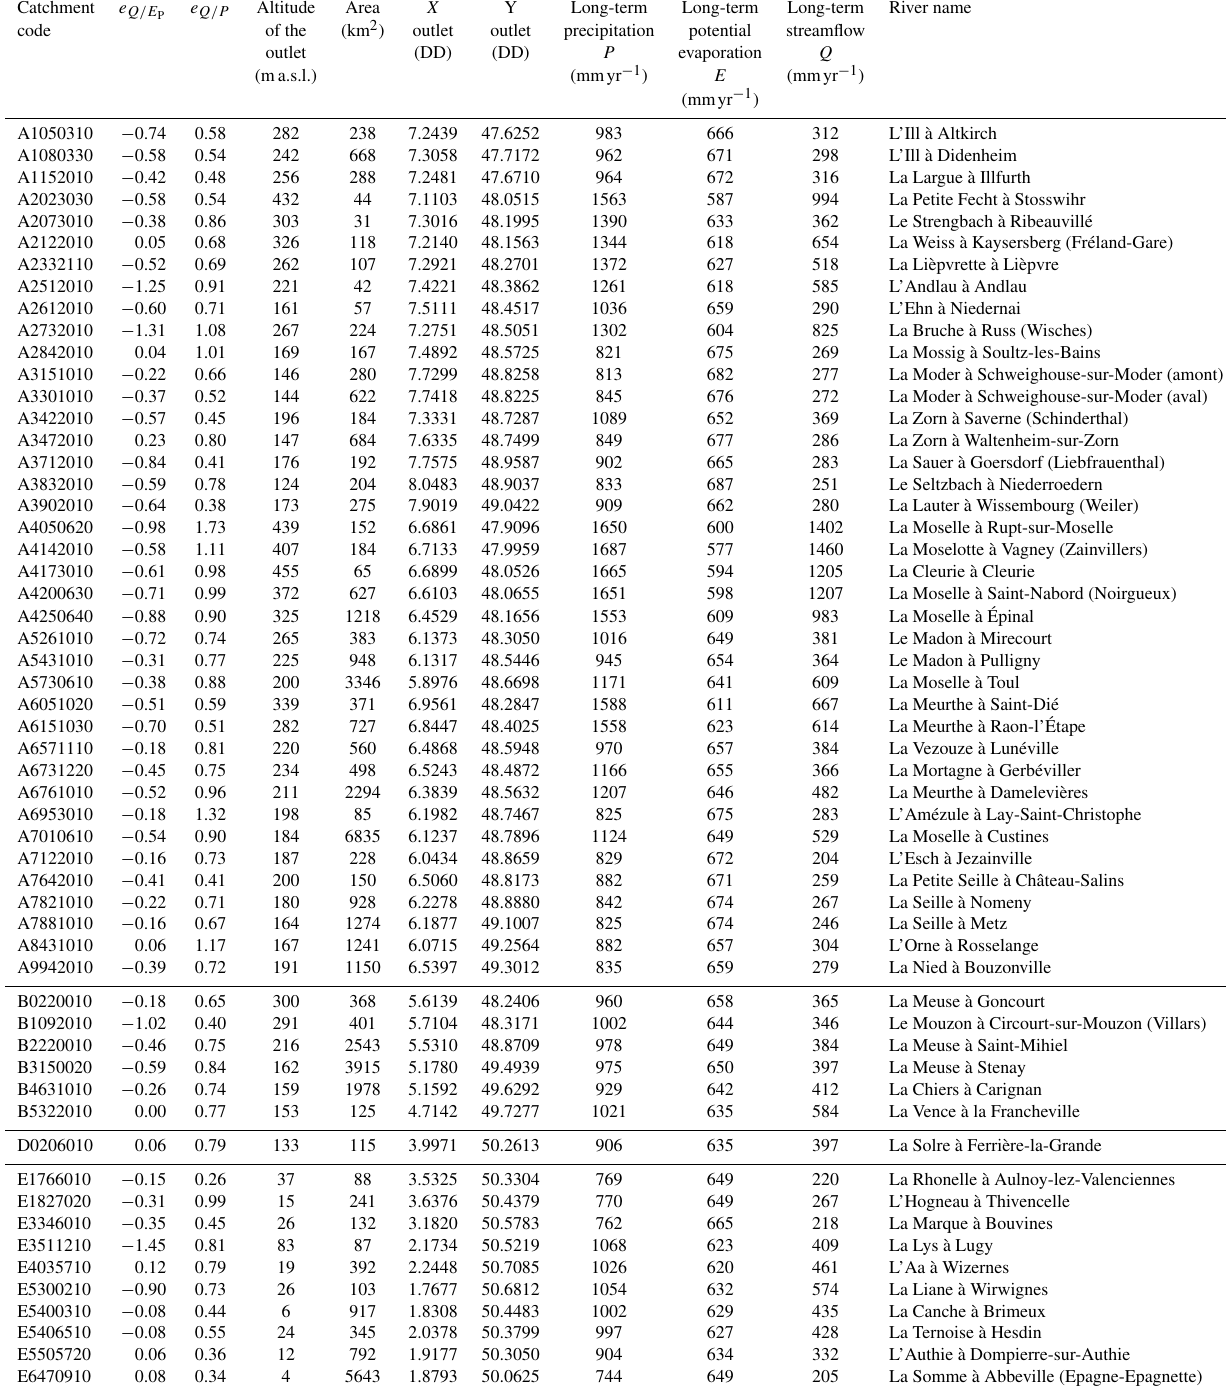
Table C1. Main characteristics of the catchment data set. Note: all long-term values have been computed over the 1986–2006 time